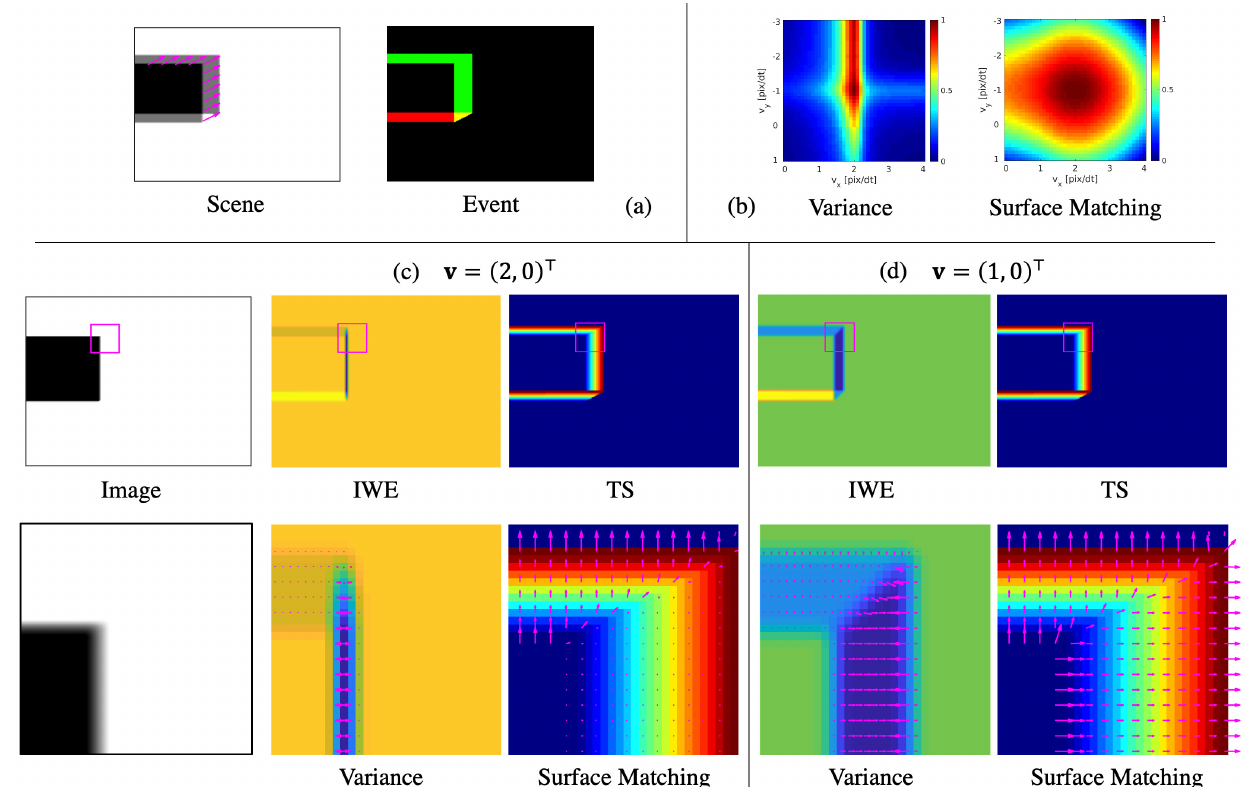
Figure 5. ( a ) Description of a rectangle scene and an event image where a rectangle is translating at v = ( 2, − 1 ) (cid:62) on the image plane. ( b ) Plots of the losses as a function of the optical flow parameters v ∈ R 2 . Each loss map is normalized by its maximum. Bottom of figure shows the brightness image, the IWE, time surface (TS) and those enlarged in a magenta patch when the loss functions are evaluated at ( c ) v = ( 2,0 ) (cid:62) (pix/ ∆ t ) and ( d ) v = ( 1,0 ) (cid:62) (pix/ ∆ t ). The magenta arrows show the gradient of variance for the IWE and Surface Matching Loss for the